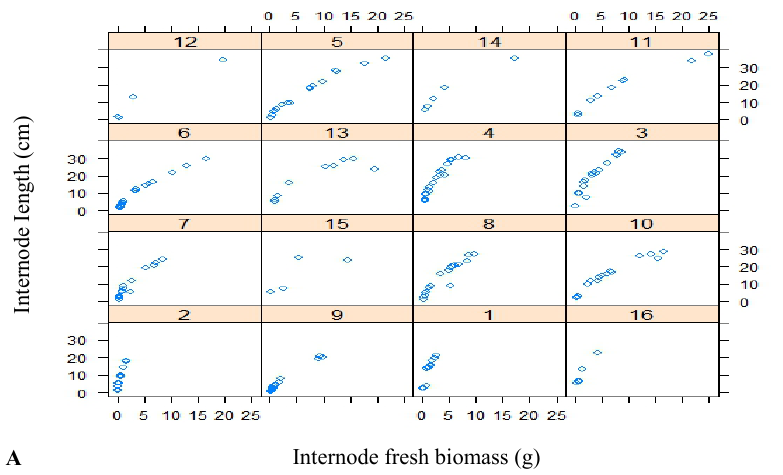
Figure 1. Scatter plots of internode length and biomass for Chinese pine ( A : the first-order branches; B : the second-order branches; C : the third-order